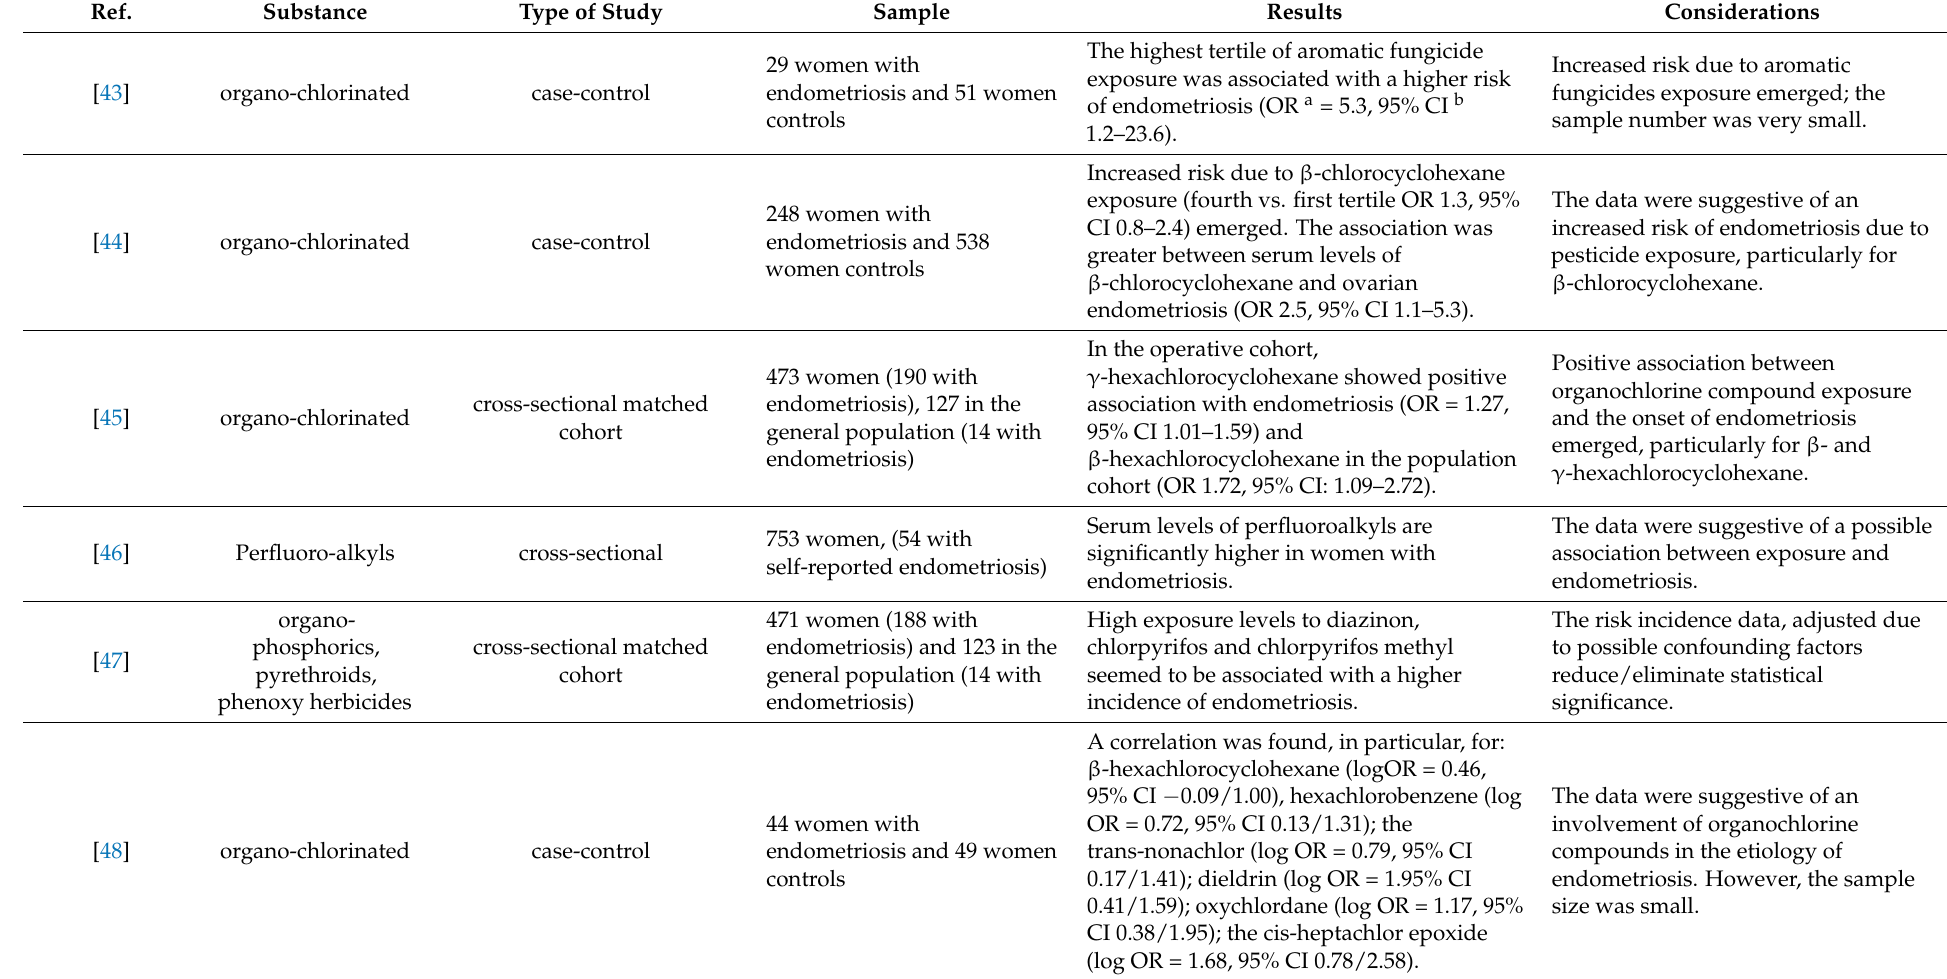
Table 3. Description of the investigations conducted with respect to organohalogen compounds and/or pesticide exposure and endometriosis.